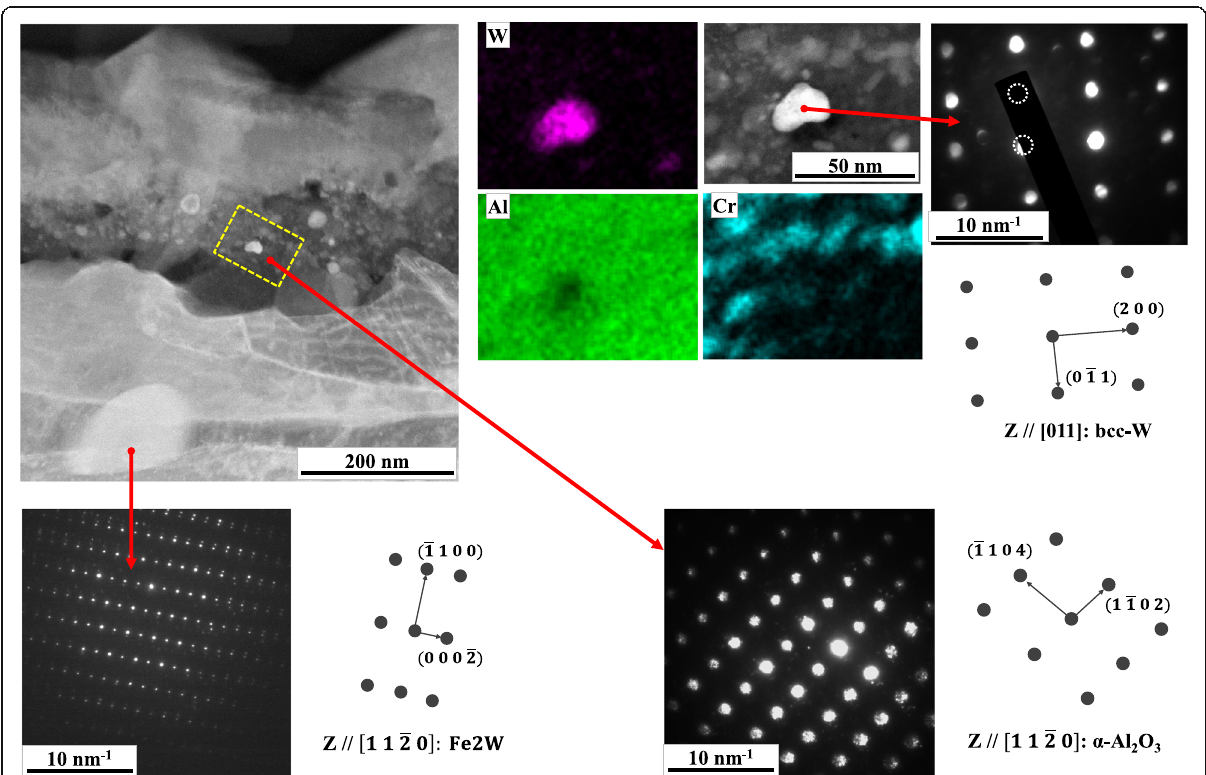
Fig. 6 Analyses on the oxides and the second phases near the metal-oxide interface of W5 after 336 h of oxidation